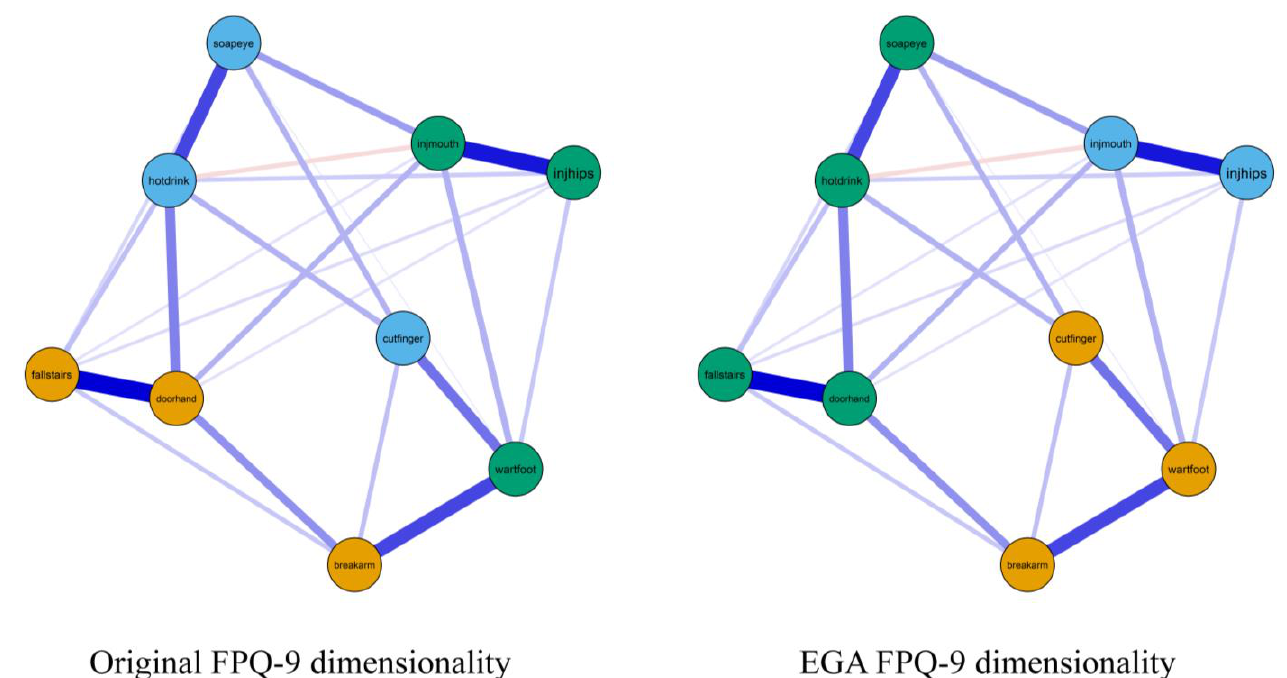
Figure 1. Networks of the Fear of Pain Questionnaire-9. Note: On the right graph, nodes were coloured according to the FPQ-9 theoretical dimensions of Fear of Medical/Dental Pain ( green ), Fear of Minor Pain ( blue ), and Fear of Severe Pain ( orange ). On the left graph, nodes were coloured according to the EGA-identified dimensions. Positive edges are displayed as blue lines, and negative edges are displayed as red lines. Edge weights are represented by the thickness and saturation of the edges. Table 2. Model fit comparison of the original FPQ structure and EGA identified